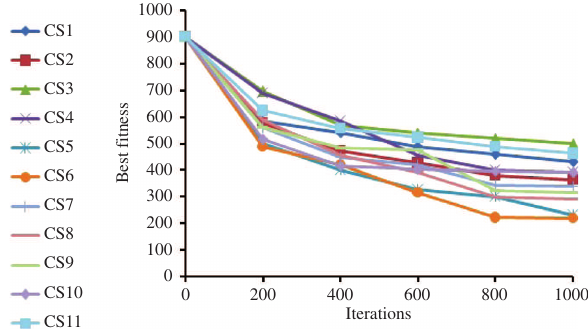
Figure 7: Convergence Trend of f 14